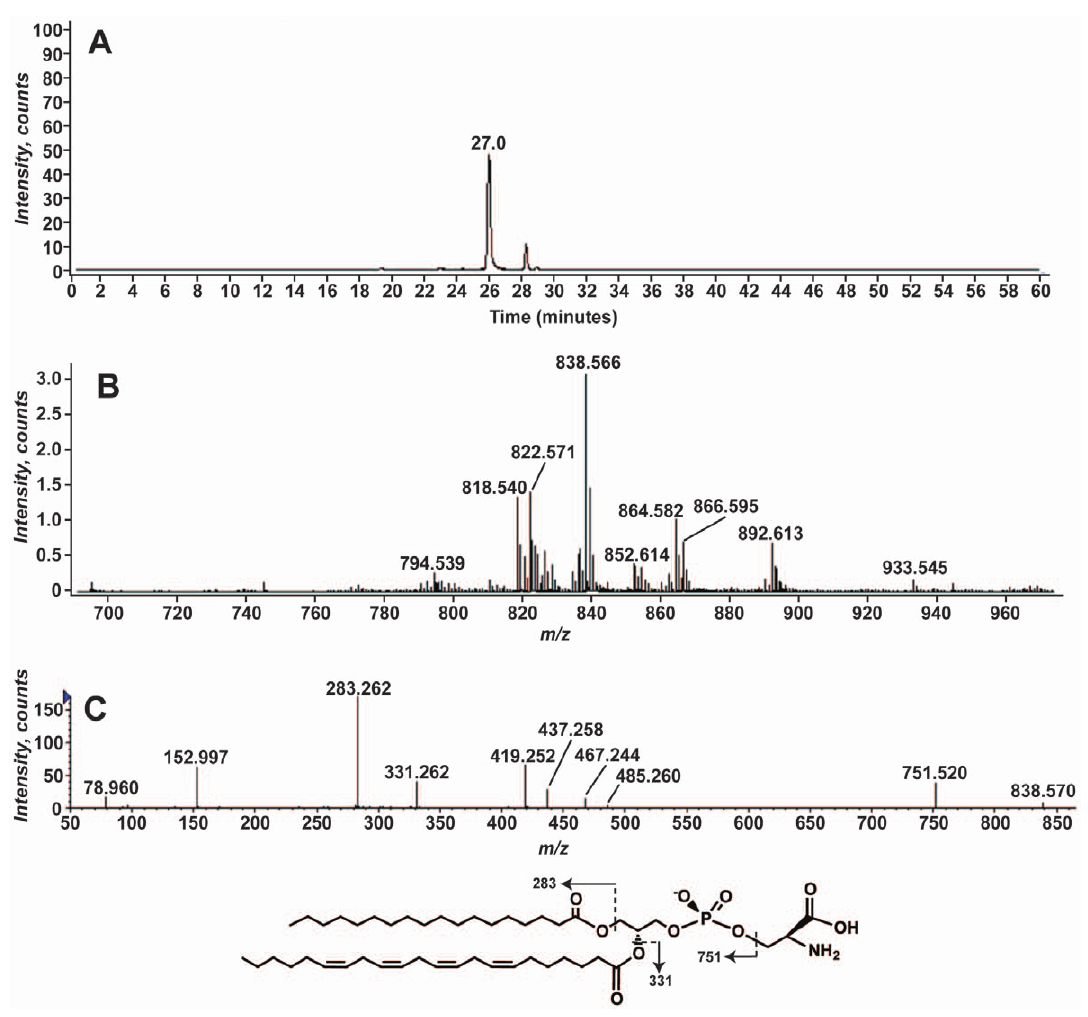
Figure 4. Phosphatidylserines identified in aposymbiotic A.pallida total lipid extracts. A. pallida total lipid extracts were analyzed as described in the legend for Figure 2. Panel A shows the EIC for m/z 838.5. Panel B shows the mass spectrum from m/z 700 to 980 for the lipids eluting between 25.6 and 26.4 minutes. The MS/MS spectrum of m/z 838.5 is shown in Panel C. The structure of the 40:4 PS is shown below with the predicted product ions. PLOS ONE |